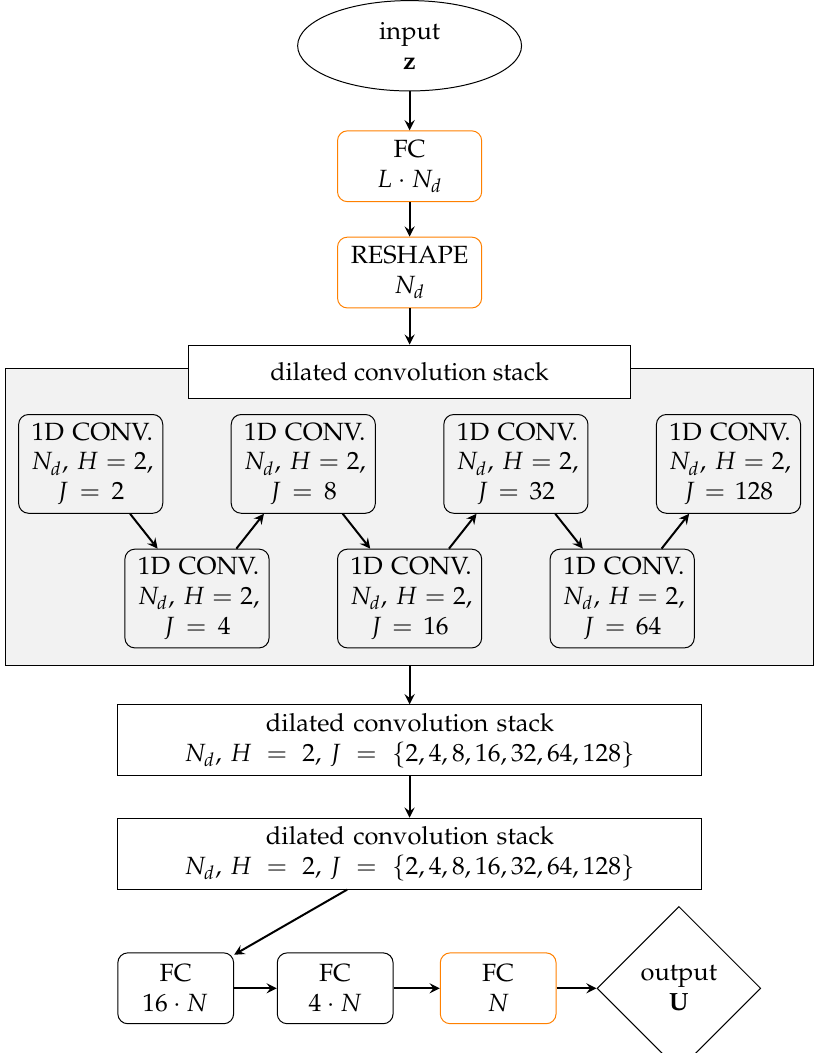
Figure 2. Architecture of the decoder. Layers are schematically represented by boxes, with the notation as detailed in the caption of Figure 1. Orange edges are used for the layers that do not apply any activation function, while the SELU is employed elsewhere. Each stack of dilated convolutions is formed by seven dilated convolutional layer, as shown in the grey